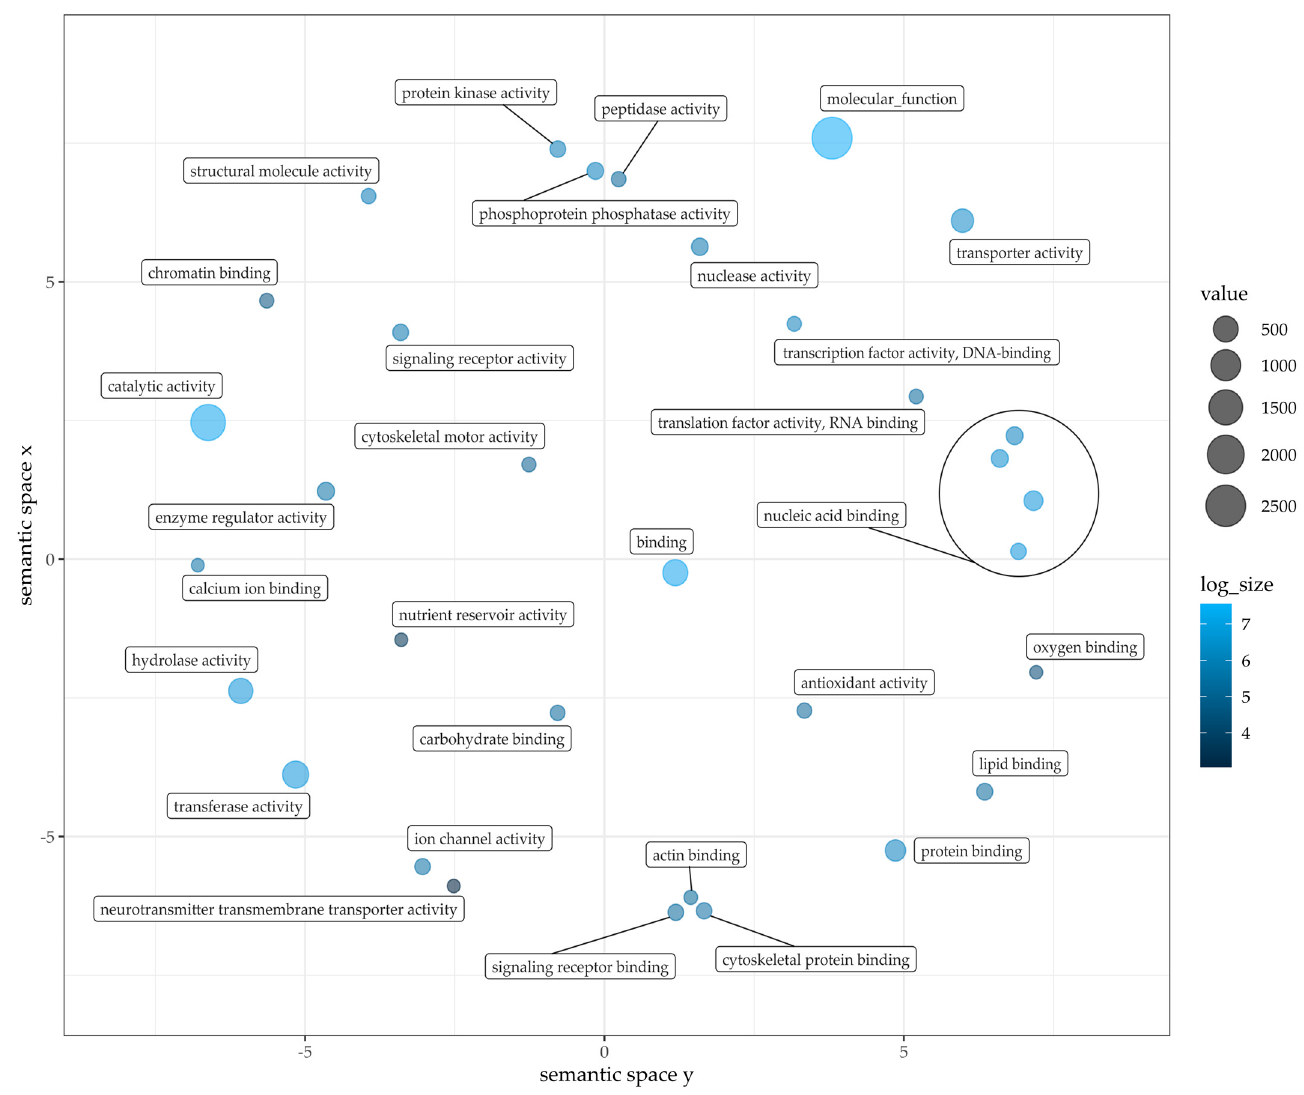
protein transport. Figure was drafted employing REVIGO [59] and customized with R. Value and log size represents the counted GO terms across annotated gene models.